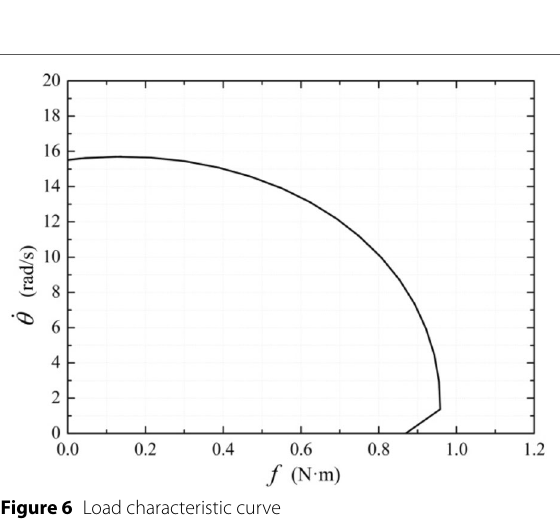
Figure 6 Load characteristic curve